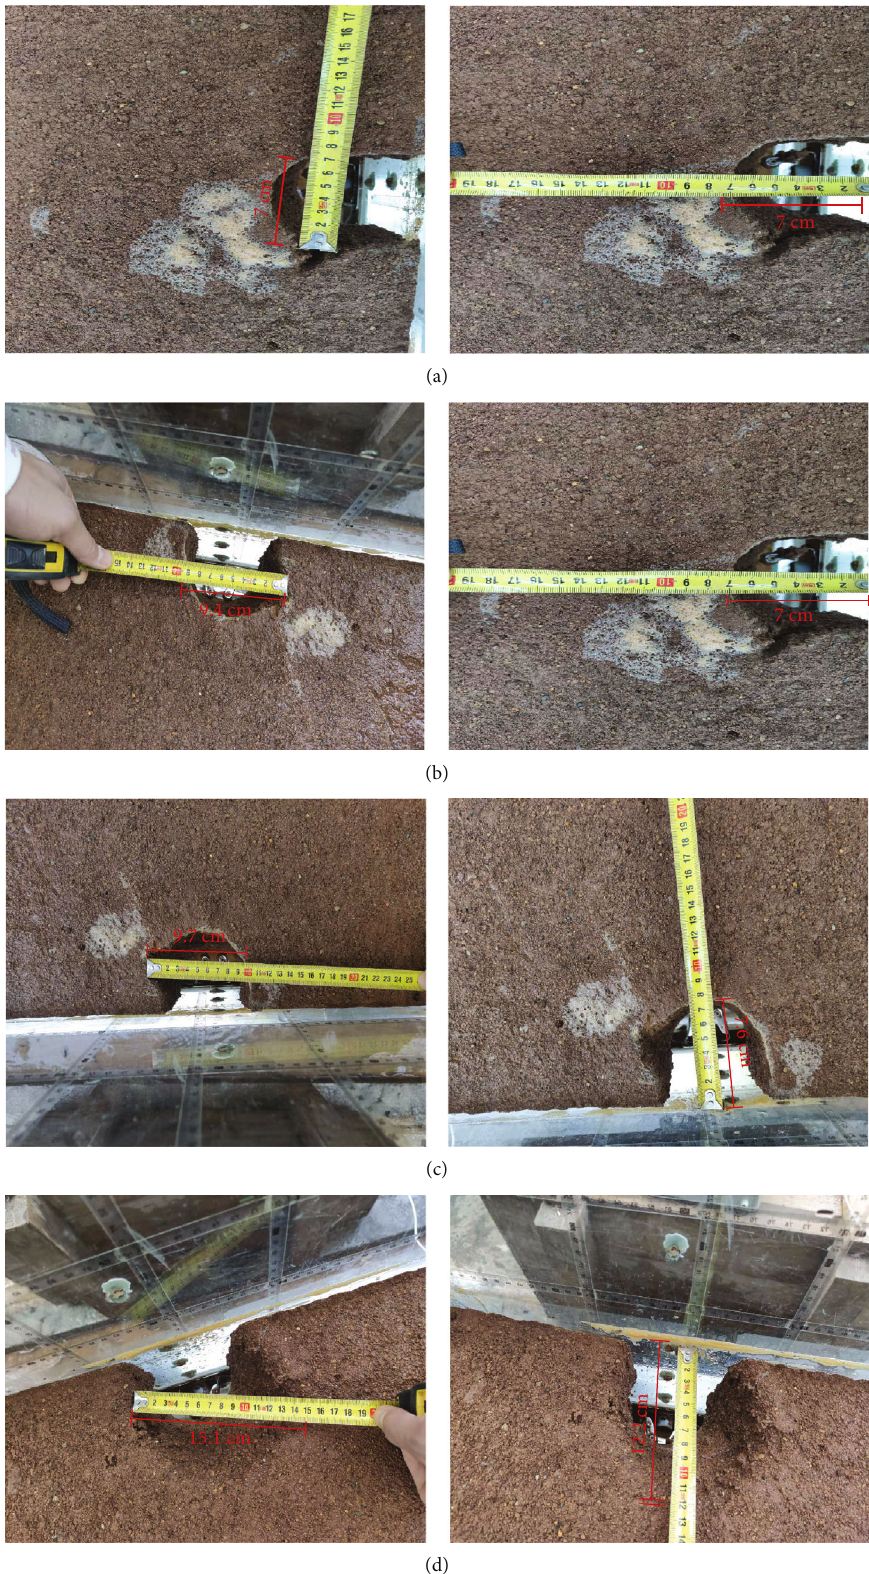
Figure 11: Dimensional measurement of collapse opening in model test. (a – d) The measured diagram of the long and short half-axis length during the collapse, one-time water level fl uctuation, two times water level fl uctuation, and three times water level fl